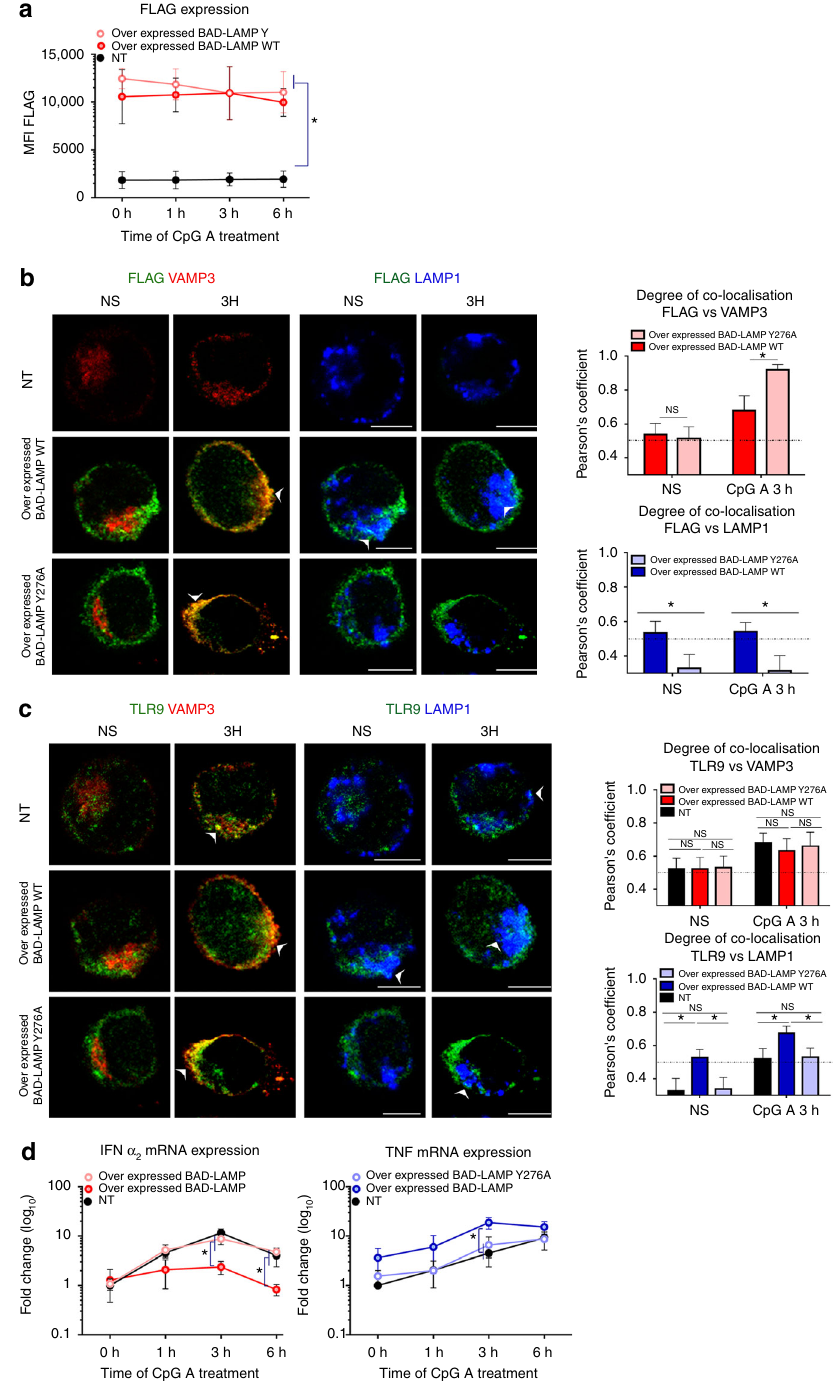
Fig. 9 BAD-LAMP Yxx Φ motif is required for TLR9 transport to LAMP1 + late endosomes. CAL-1 cells were electroporated with FLAG BAD-LAMP WT or FLAG BAD-LAMP Y276A mRNAs for 6 h prior stimulation for indicated times with CpG-A. Mock electroporated cells (NT) are used as control. a BAD-LAMP ectopic protein expression were monitored by intracellular fl ow cytometry with FLAG tag antibody. Graphic represents means of MFI ± s.d. from at least two independent experiments. b , c ( left ) Immuno fl uorescence confocal microscopy on CAL-1 cells. Staining for LAMP1, VAMP3, FLAG ( b ) or TLR9 ( c ) are shown. Pictures are representative of at least two independent experiments. White arrows identify co-localisation area. Scale bars = 5 μ M. ( right ) Quanti fi cation of the co-localisation between FLAG ( b ) or TLR9 ( c ) with VAMP3 ( top ) or LAMP1 ( bottom ) at steady state (NS) and 3 h after CpG-A stimulation was performed by Pearson ’ s coef fi cient measurement using ImageJ. Graphics represents mean of Pearson ’ s coef fi cient of at least 25 cells ± s.d. for all time points. d IFN α 2 ( left ) and TNF ( right ) mRNA level were monitored by RT-QPCR. Raw data have been normalised to housekeeping gene (GAPDH) and graphics represent fold change ± s.d. compare to non-stimulated cells from two independent experiments. * P < 0.05 by unpaired student ’ s t